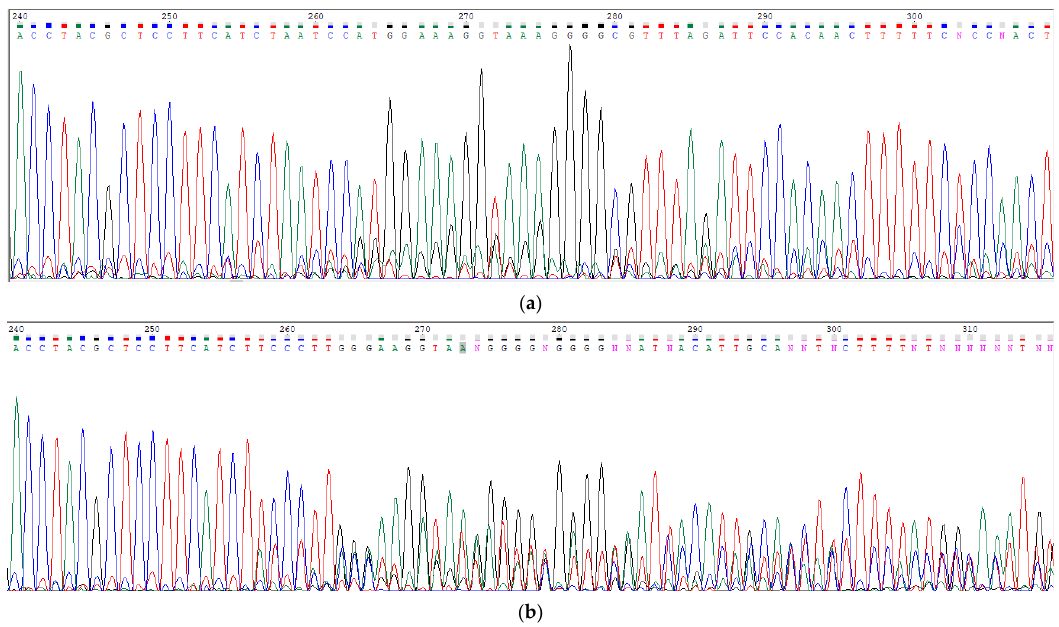
Figure 2. Example of DNA sequences of the targeted region in the MTTP gene, obtained by the Sanger sequencing method. Cells were cultured in Petri dishes to reach confluence, and DNA was extracted from each transgenic clone and wild-type Caco-2/TC7 cell (WT), which was used as a control. ( a ) The targeted DNA sequence of wild-type cells in the MTTP gene shows a fully determined unique sequence. ( b ) The targeted DNA sequence in the MTTP gene in clone MTTP -KO1 shows overlapping disrupted sequences beginning at nucleotide 258. The putatively mutated clones were therefore selected for a wider characterization. At this step, 13 clones transfected with the MTTP -gRNA and 12 transfected with the SAR1B -gRNA displayed disrupted sequences. We then analyzed CRISPR edits using Sanger data with the “Inference of CRISPR Edits” (ICE) tool, wh ich estimates the frequency of impaired genotypes given the cut site. This analysis confirmed the absence of non-mutated sequences for MTTP -KO1 and MTTP -KO2 and showed the presence of non-mutated sequences for SAR1B -KO1 and SAR1B -KO2 at a lower frequency than mutated sequences, confirming a good knock-out efficiency. Western blotting was then performed on the selected clones to detect the effect of mutations introduced with the CRISPR/Cas9 gene editing system on the expression of proteins of interest (Figure 3a,b). No detectable amount of MTP was observed on two clones, and no detectable amount of Sar1b was observed on two other clones, indicating a successful MTTP or SAR1B gene knock-out. These four clones were selected for further work and named clones MTTP -KO1 and MTTP -KO2 and clone SAR1B -KO1 and SAR1B - KO2.